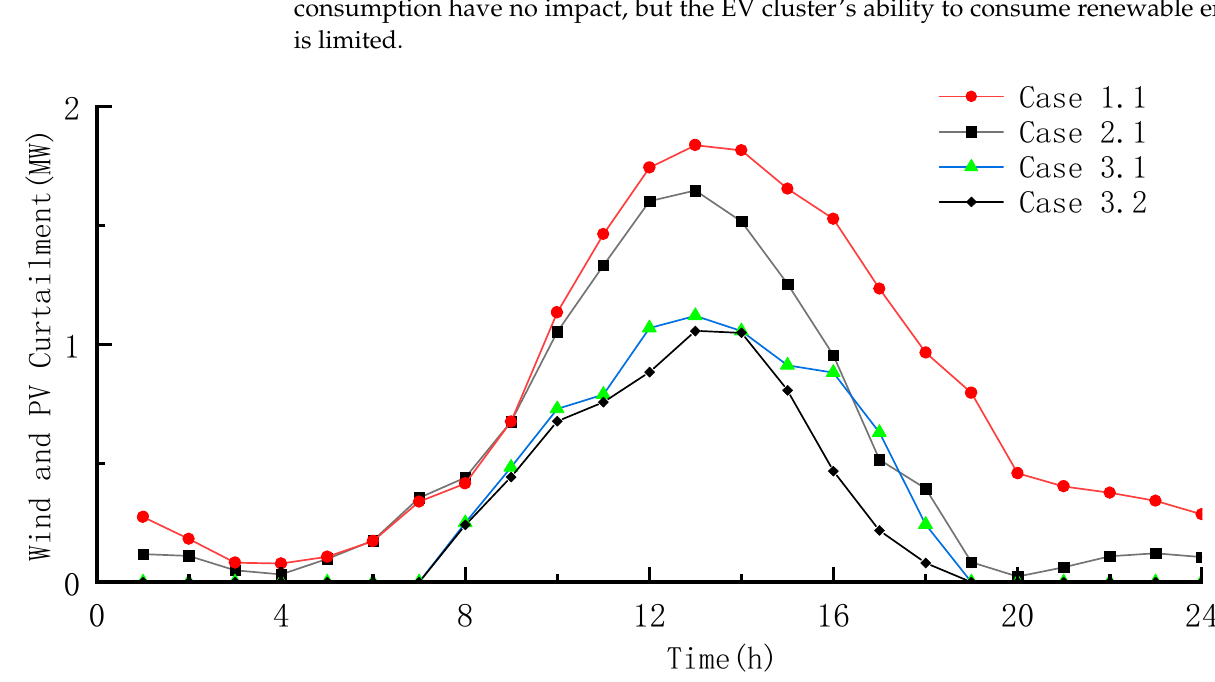
Figure 6. Wind and PV curtailment in Case 3.